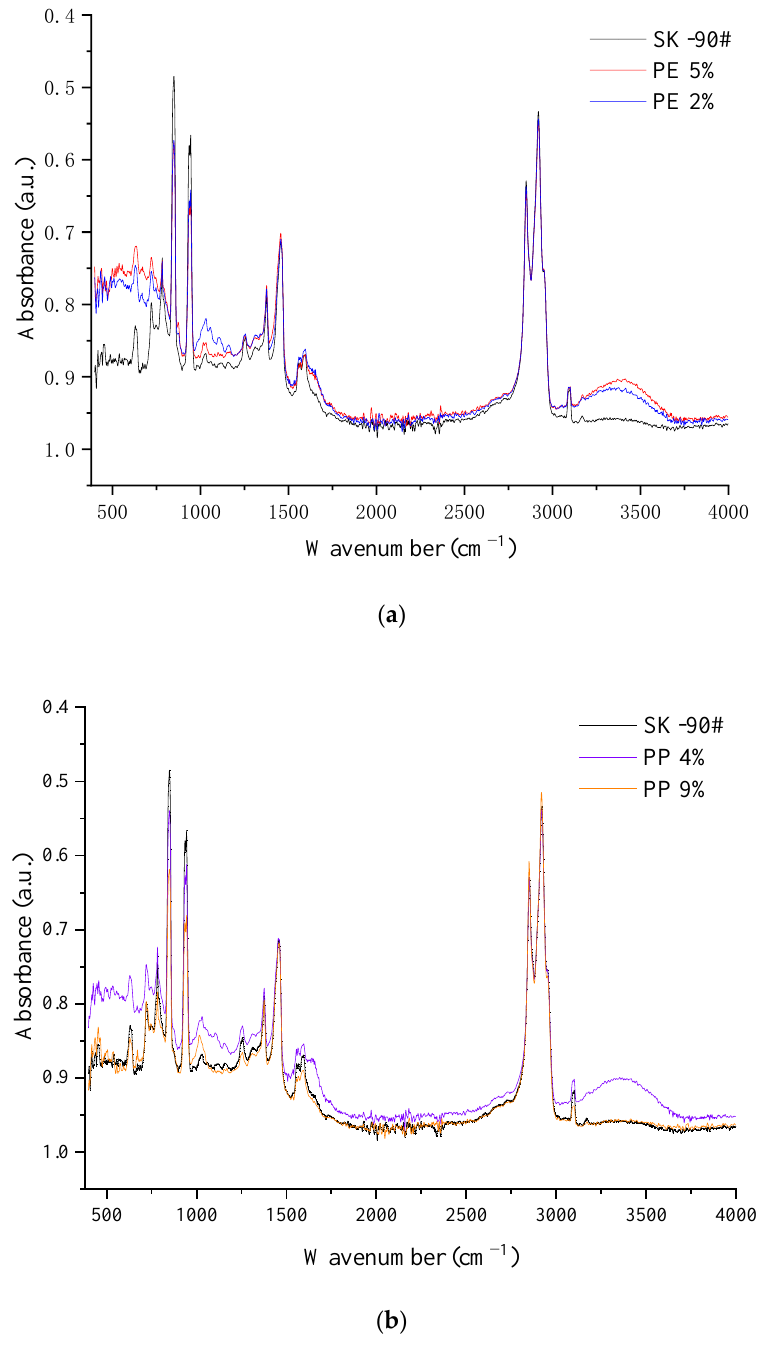
Figure 8. The functional groups change of plastic-modified asphalt and matrix asphalt. ( a ) PE-modified asphalt and SK-90#. ( b ) PP-modified asphalt and SK-90#.